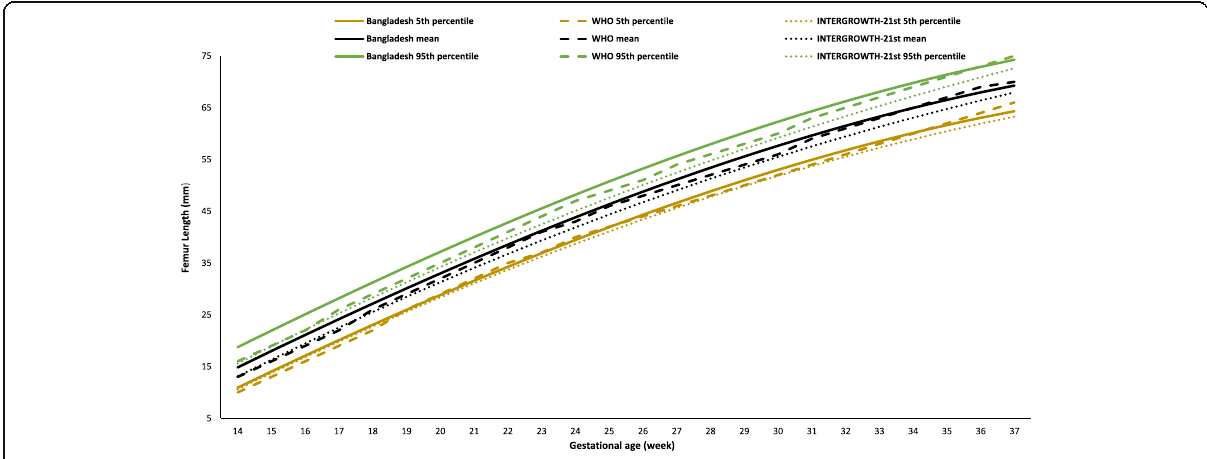
Fig. 5 Comparison of femur length (FL) with WHO [11] and INTERGROWTH-21st [16]